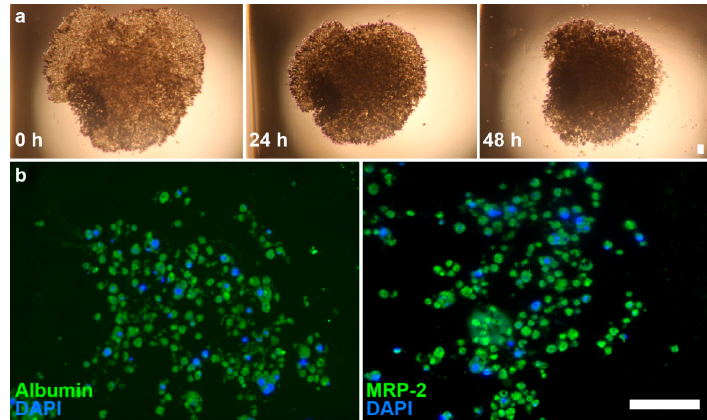
Figure 2. Brightfield images of primary hepatocyte spheroids and immunofluorescence images of spheroid sections. ( a ) Images of hepatocyte spheroids at 0, 24, and 48 h show contraction of structure; ( b ) Immunofluorescence shows presence of albumin (left, green) and MRP2 (right, green) on sections. Nuclei (blue) were counterstained with DAPI. Scale bar = 50 µm.